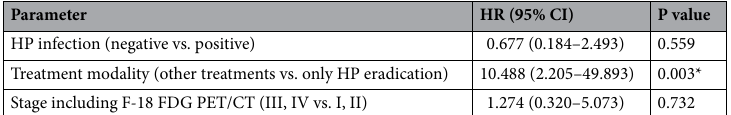
Table 3. Multivariate analysis for DFS. DFS, disease free survival; HR, hazard ratio; CI, confidence interval; HP, helicobacter pylori ; F-18 FDG, fluorine-18-fluorodeoxyglucose; PET, positron emission tomography; CT, computed tomography. *Multivariate analysis using Cox proportional-hazards regression with enter method, P < 0.05.